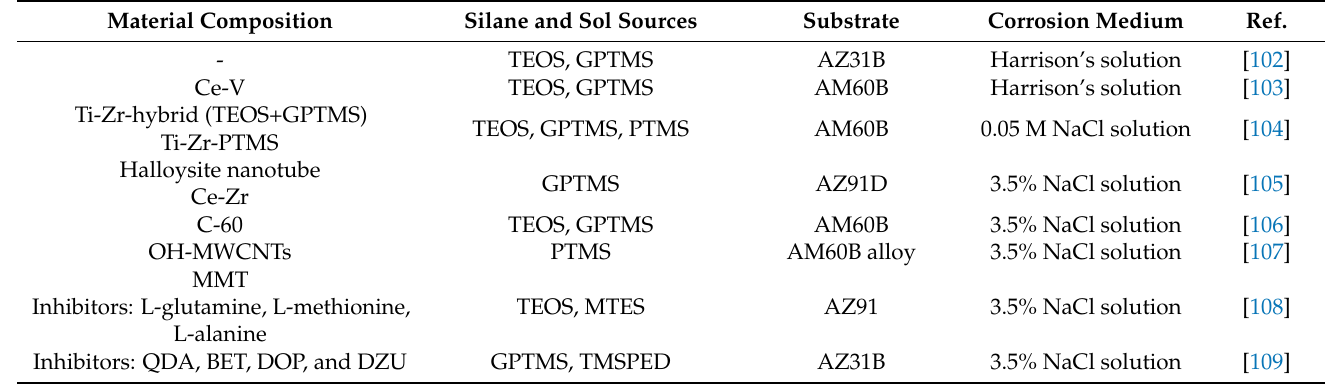
Table 4. Studies on corrosion resistance using hybrid sol-gel coating on magnesium substrates. Material Composition Silane and Sol Sources